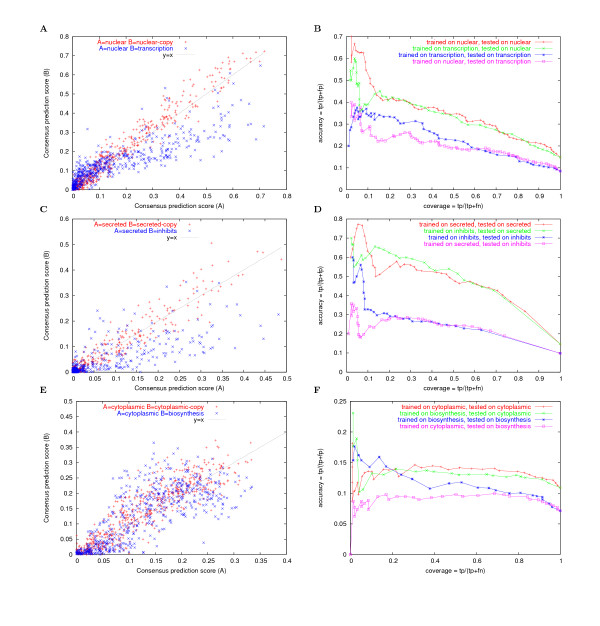
Comparison of location vs. function predictors. In panel A, the consensus prediction scores from two different fixed-target predictors over 537 test set sequences are shown in scatter plot form. The red points show scores for two identical but independently trained "nuclear" predictors. As expected, a strong correlation exists between the scores of these two predictors. The blue points show scores from a "nuclear" predictor plotted against the scores from a "transcription" predictor. The scores are still quite well correlated but the distribution of points mainly below the diagonal suggests that proteins that get high scores for "nuclear" do not always have equally high scores for "transcription", which agrees with general observations that not all nuclear proteins are involved in transcription (but all transcription proteins are nuclear). In panel B, accuracy vs. coverage plots are shown for the four combinations of predictors trained and/or tested on "nuclear" and/or "transcription". The data shown here are for the pooled test set proteins from a four-fold cross-validation experiment. The noteworthy result here is the increased performance of the "transcription"-trained predictor (blue line) compared to the "nuclear"-trained predictor (magenta line) when predicting "transcription". Panels C & D show the equivalent data for "secreted" vs. "inhibits" predictors Panels E & F show the data for "cytoplasmic" vs. "biosynthesis" predictors.